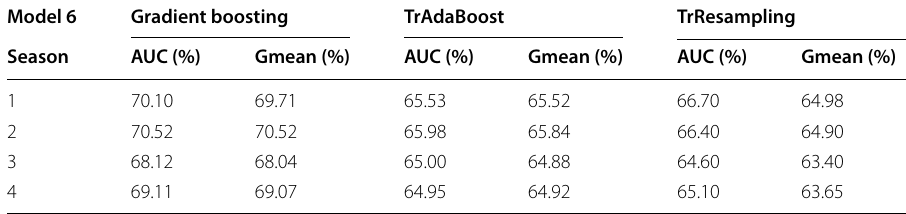
Table 9 AUC score and Gmean based on multisource data (model 6) Model